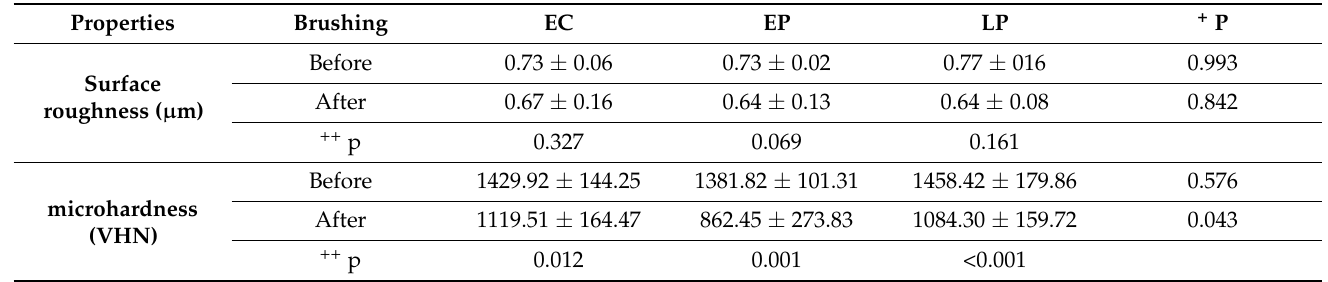
Table 2. Toothbrushing effects the surface characteristics of all tested